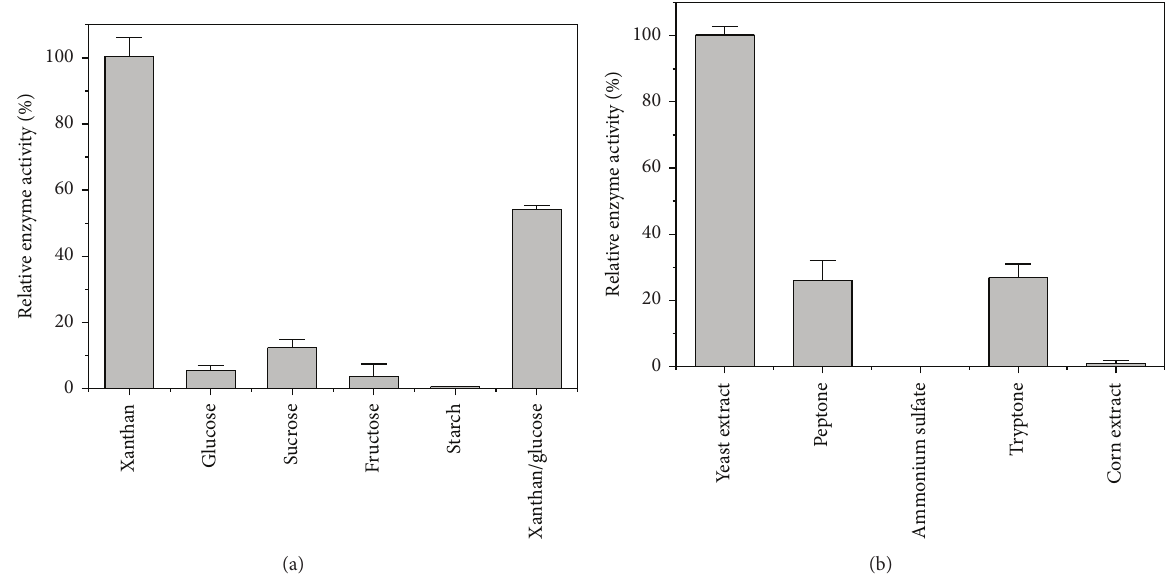
Figure 2: Xanthan lyase production when Microbacterium sp. XT11 was cultured in the medium with different carbon sources (a) and various nitrogen sources (b) shaking at 30 ∘ C.